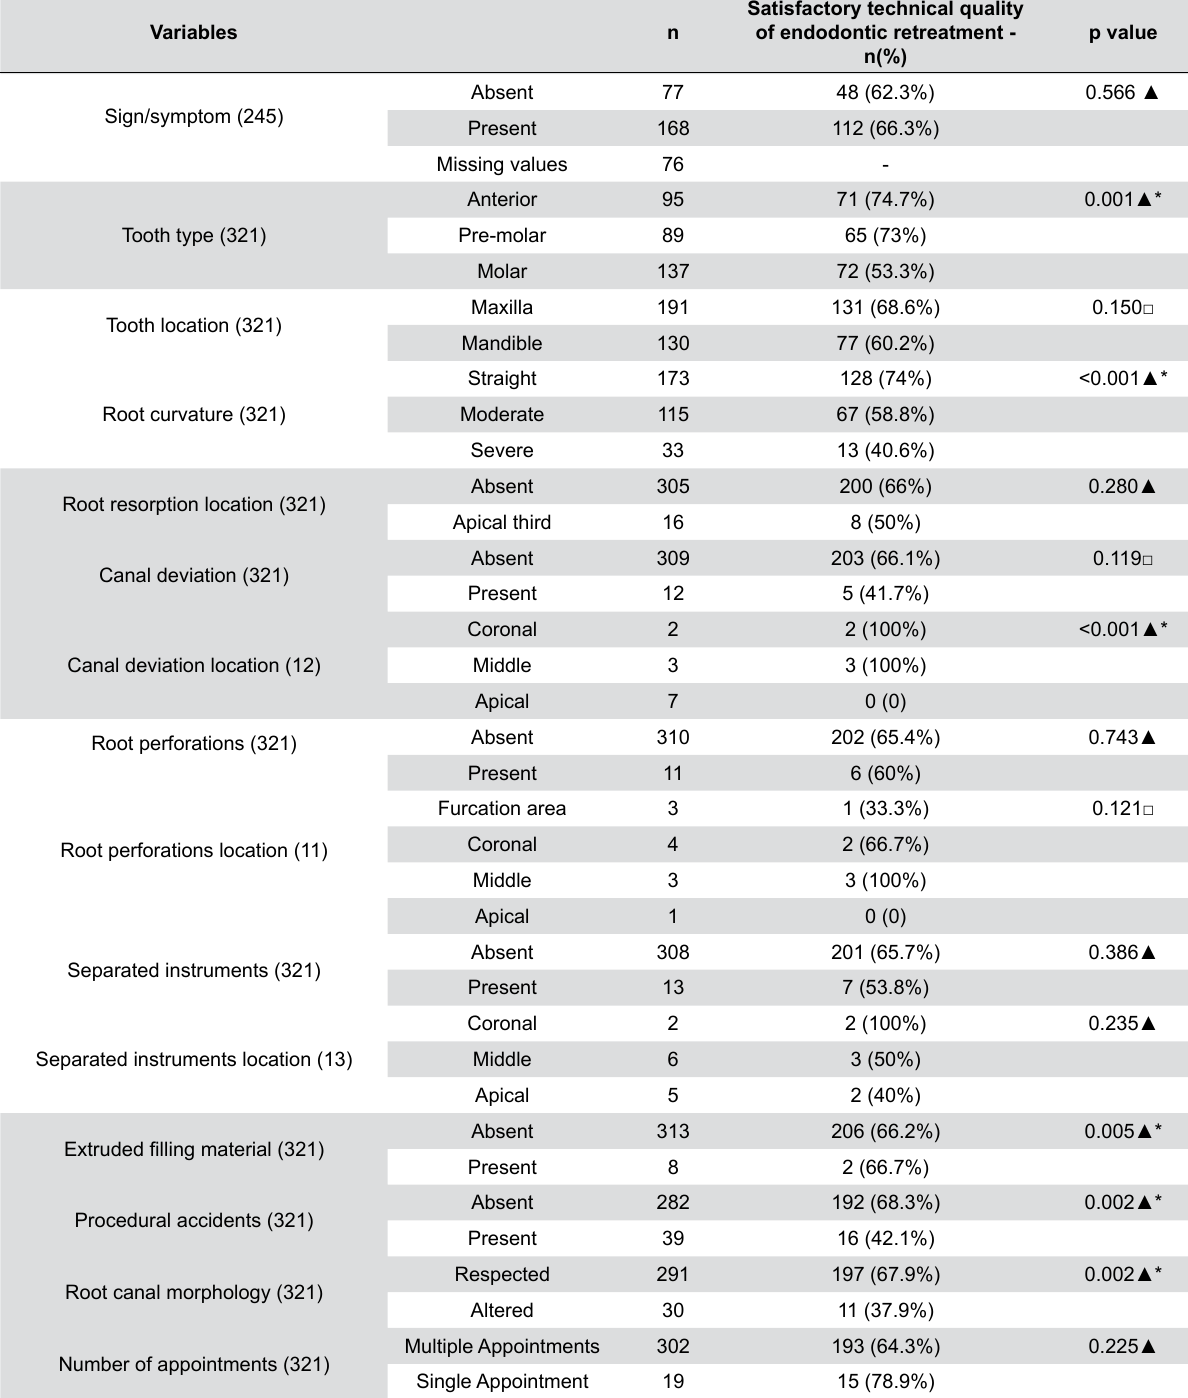
SIGNOR B, BLOMBERG LC, KOPPER PM, AUGUSTIN PA, RAUBER MV, RODRIGUES GS, SCARPARO Table 2- Prognostic factors associated with the technical quality of endodontic retreatment (N = 321)